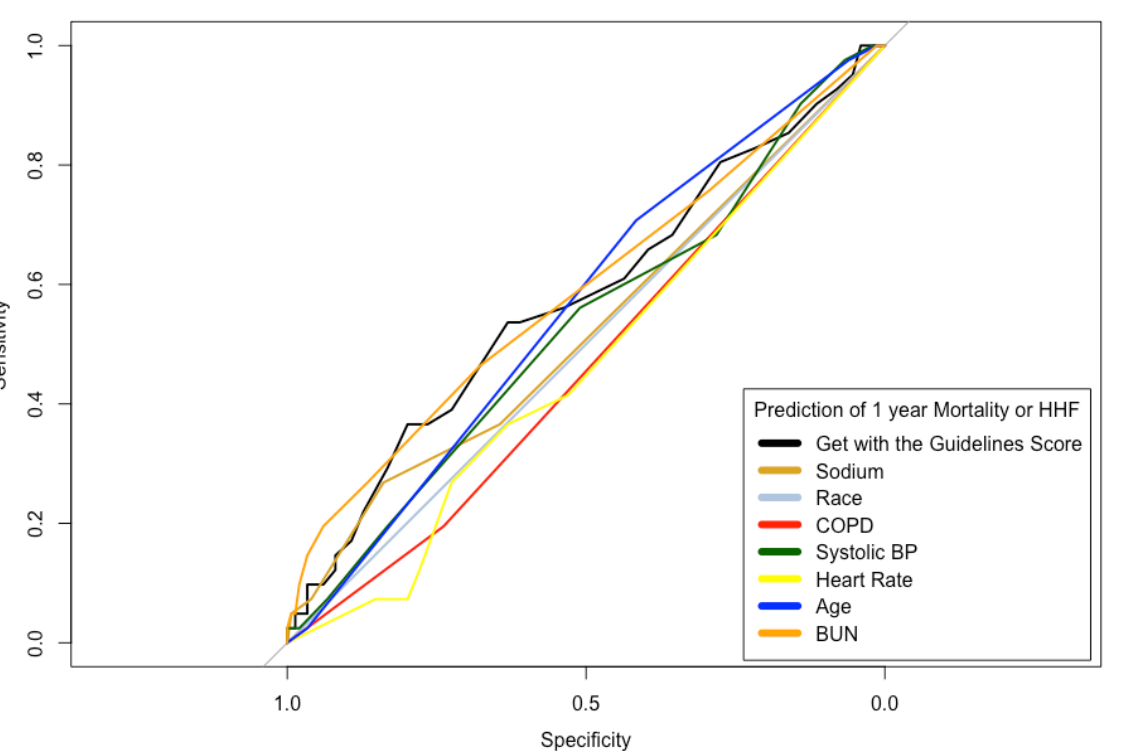
Figure 1. Prediction of mortality. COPD = chronic obstructive pulmonary disease; BP = blood pressure; BUN = blood urea nitrogen. ROC analysis for prediction of mortality (AUC 0.65) with GWTG risk score and its predictor variables.